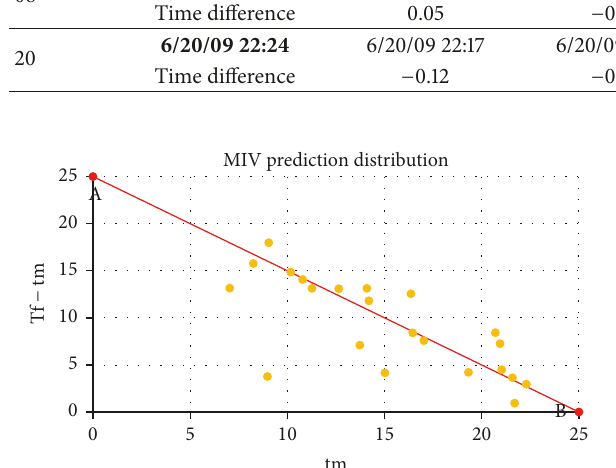
Figure 7: Distribution of failure predictions using MIV method. Line AB represents failure time.